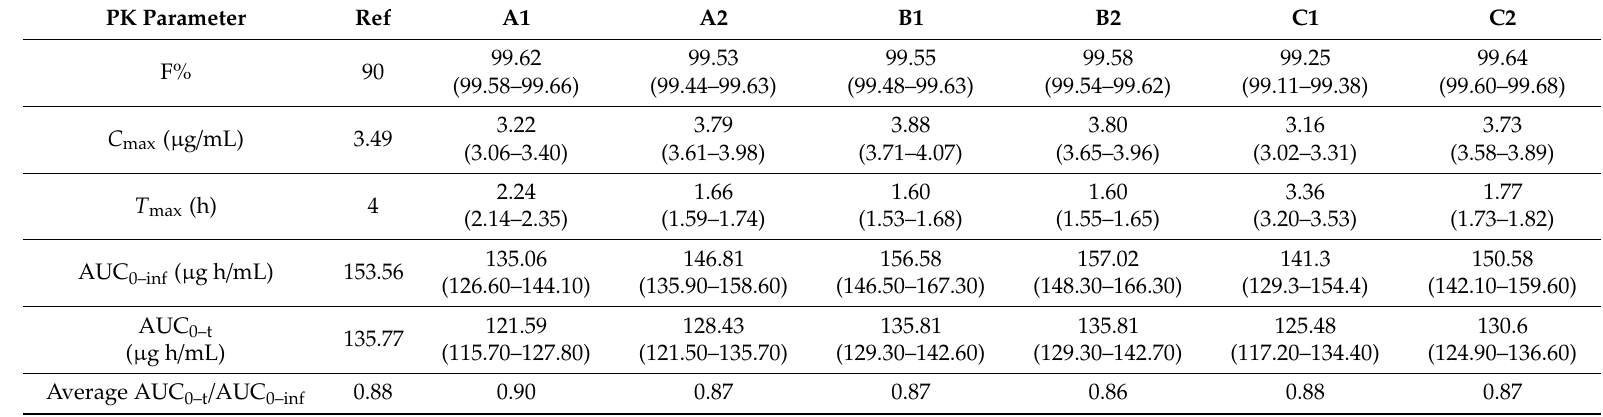
Table 6. Population simulation results: average pharmacokinetic (PK) parameters F%, C max , T max , AUC 0–inf , AUC 0–t , 90% CI ln-transformed for their ratio for A1, A2, B1, B2, C1, C2, and the reference product (Ref), and average AUC 0–t / AUC 0–inf